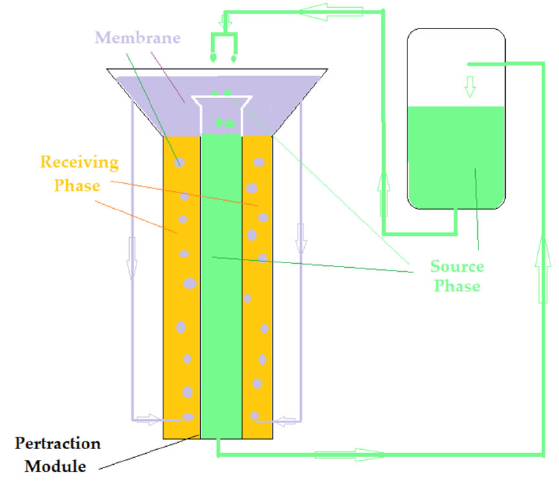
Figure 3. Schematic of the pertraction installation, which uses a module with phases in dispersion.